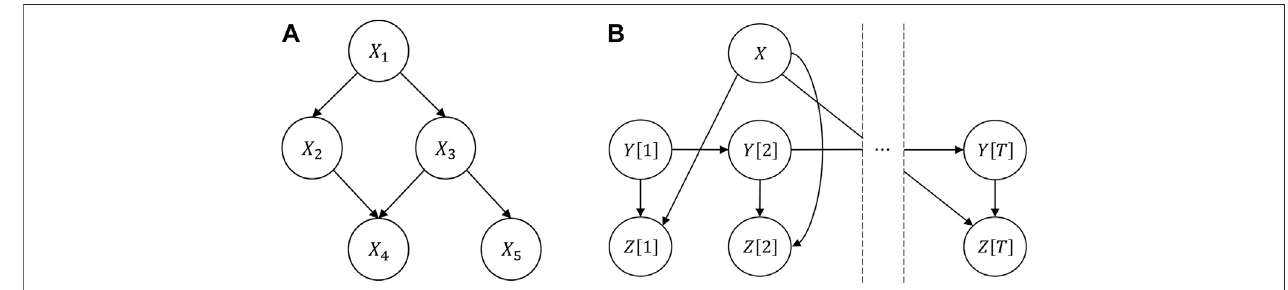
FIGURE2|(A) BasicexampleofaBayesian network.Nodes X (cid:1) { X 1 , X 2 , X 3 , X 4 , X 5 } representtherandomvariablesofthemodel. X 5 isthechildnodeof X 3 , X 2 and X 3 have X 1 as the parent node, and X 4 as the child node (B) Example of a Dynamic Bayesian Network (DBN). The DBN network models the probabilities of the random variables Y [ t ] and Z [ t ] as it evolves discretely over each time instant t ∈ { 1 , 2 , / , T }